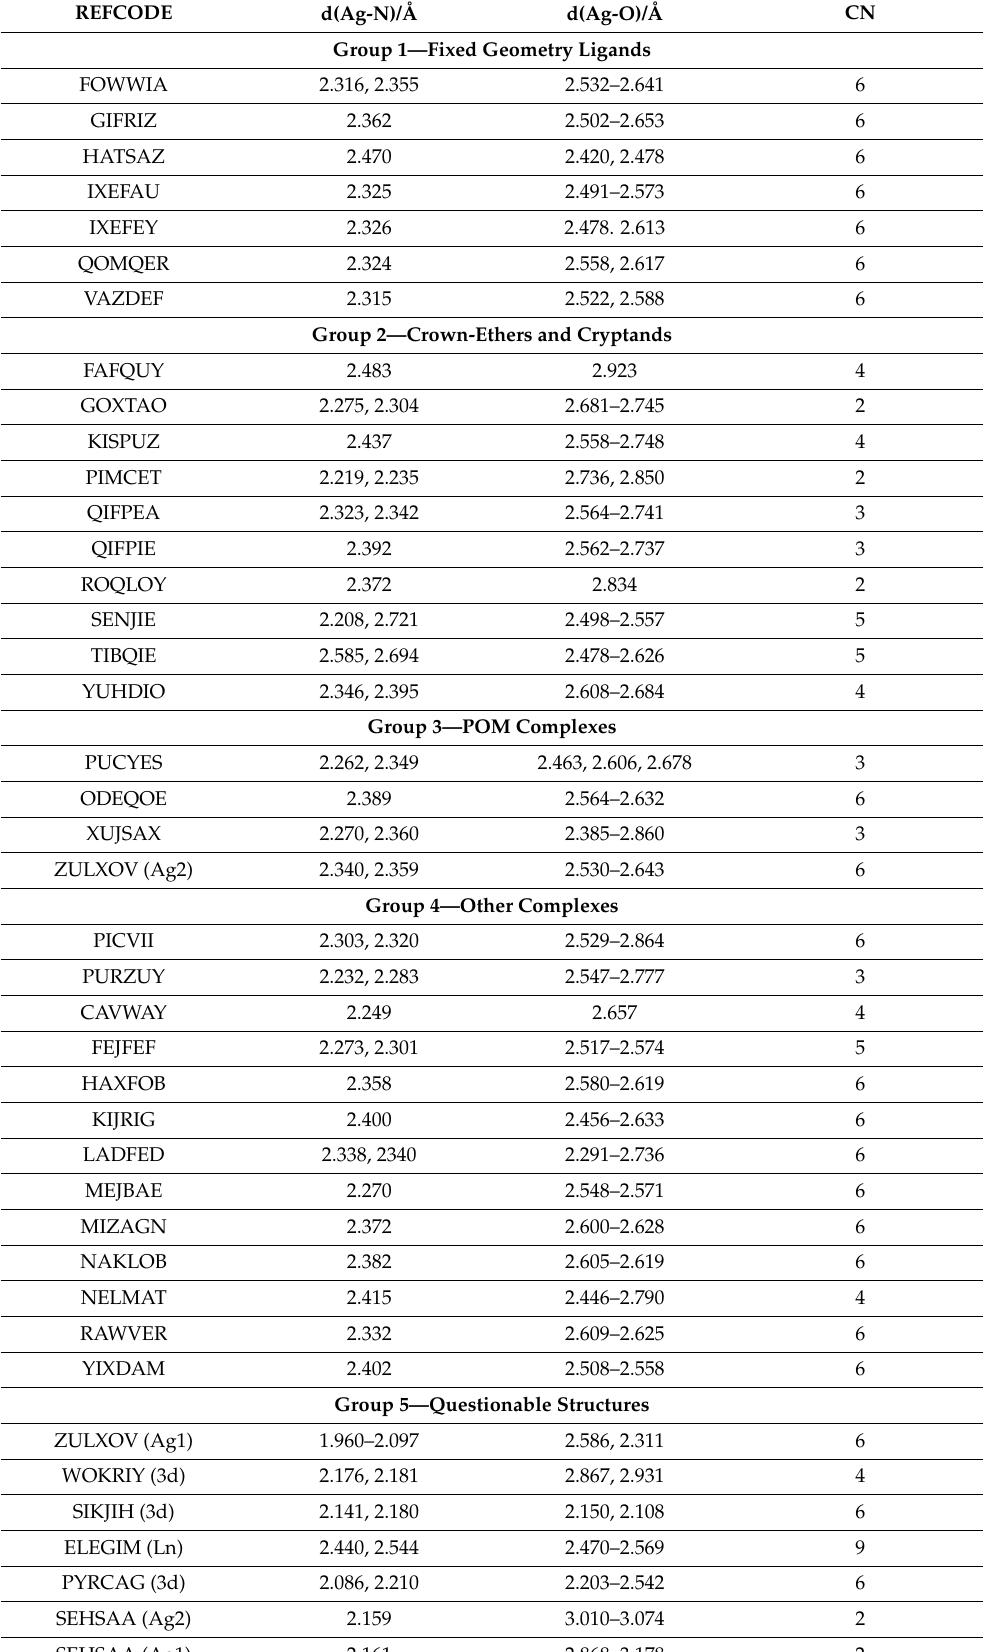
Table 1. The analysis of CCDC data for Ag complexes with two N and four O-atoms in the coordina- tion